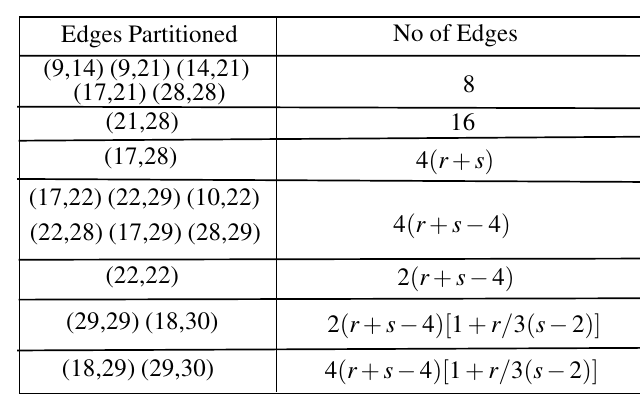
Table 4: Edge Partition of Semi-total(line) graph of 2D-Lattice for Neighborhood vertices (b) r > 1 and s >